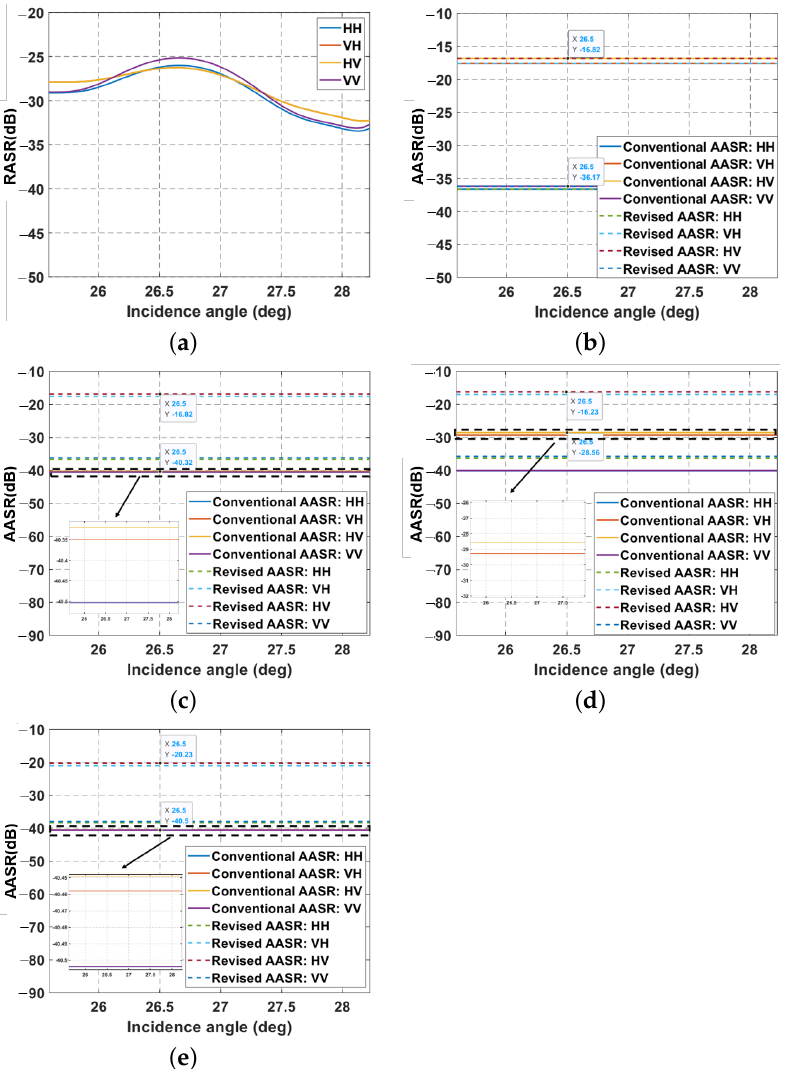
Figure 9. RASRs and AASRs for the LT-1 system operating in the hybrid quad-pol. ( a ) RASRs. ( b ) AASRs without waveform diversity. ( c ) AASRs with up-down chirp waveforms. ( d ) AASRs with OFDM chirp waveforms. ( e ) AASRs with quasi-orthogonal NLFM